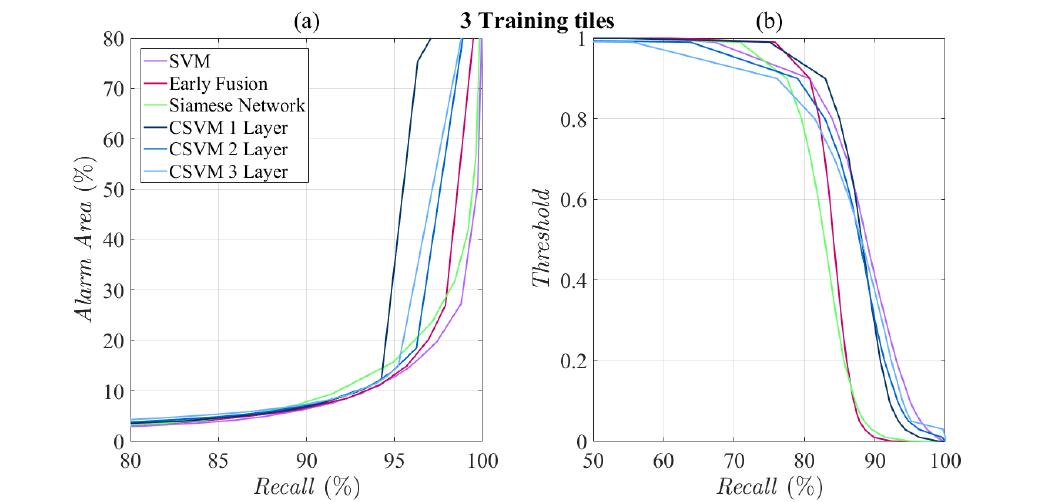
Figure 15. ( a ) Recall vs. Alarm Area (deforested area) for Amazon biome using three training tiles. ( b ) The recall values are obtained by threshold variation.